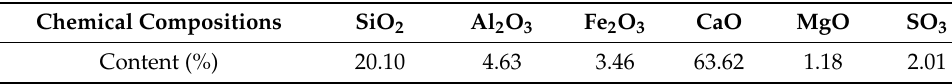
Table 1. Chemical composition of cement.